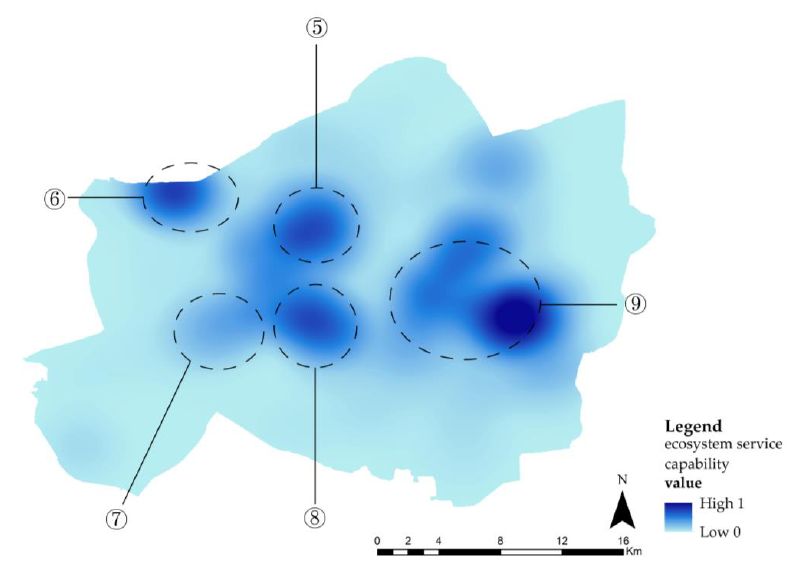
Figure 6. Distribution of the leisure and recreation capacity.